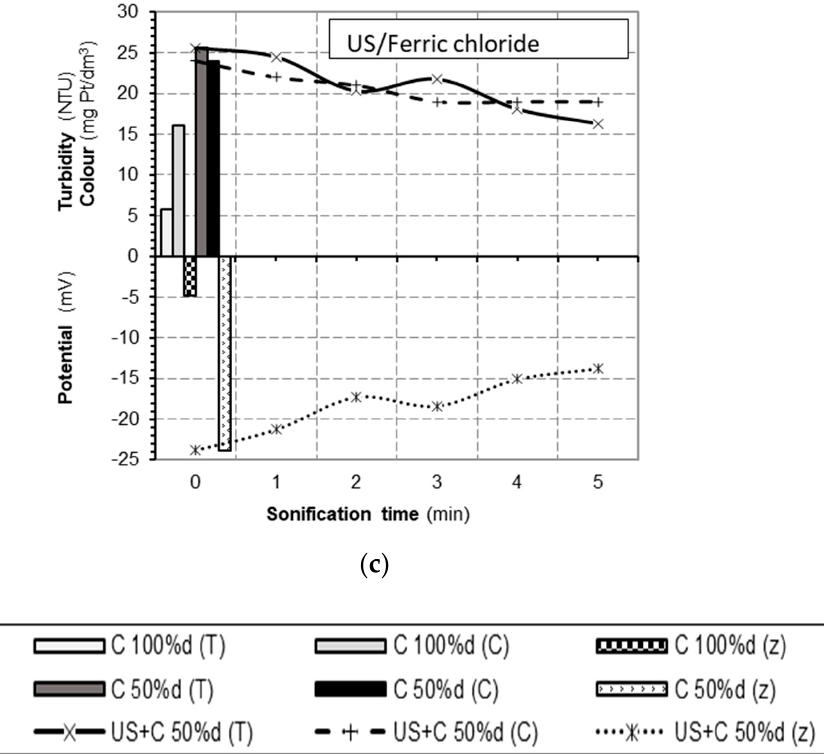
Figure 3. Changes in color (C), turbidity (T), and electrokinetic potential ζ (z) depending on the sonication time in the coagulation-associated systems, ultrasound exposure + coagulant US/C (water with initial turbidity of 29.5 NTU and initial color of 38 mg Pt/L): ( a ) US/Al; ( b ) US/WAC ® HB; and ( c ) US/Fe .